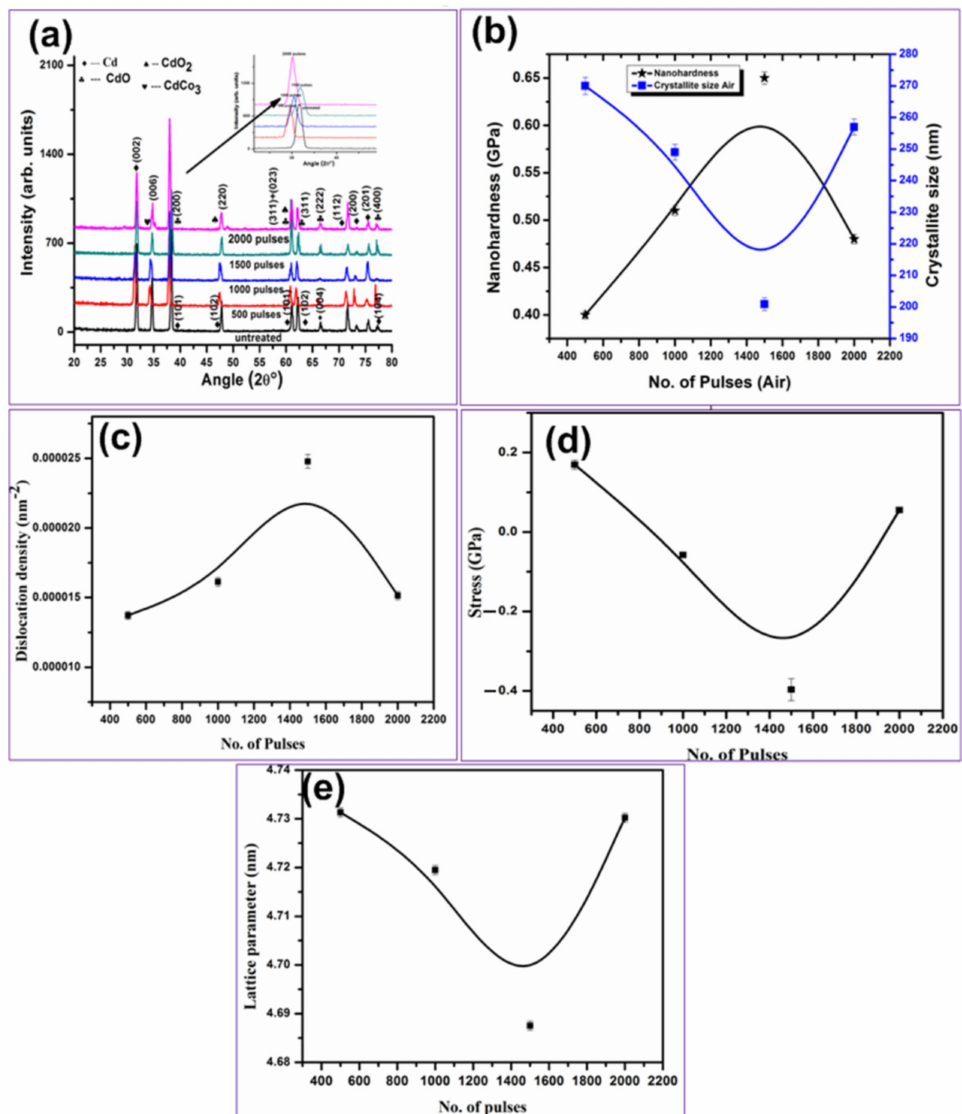
Figure 6. XRD patterns of unirradiated and laser-ablated Cd exposed for 500, 1000, 1500 and 2000 laser pulses, at constant fluence of 3.6 J cm − 2 in air ( a ) X-ray differactograms, ( b ) the variation in crystallite size and hardness, ( c ) variation in D.D, ( d ) variation in stresses and ( e ) variation in lattice